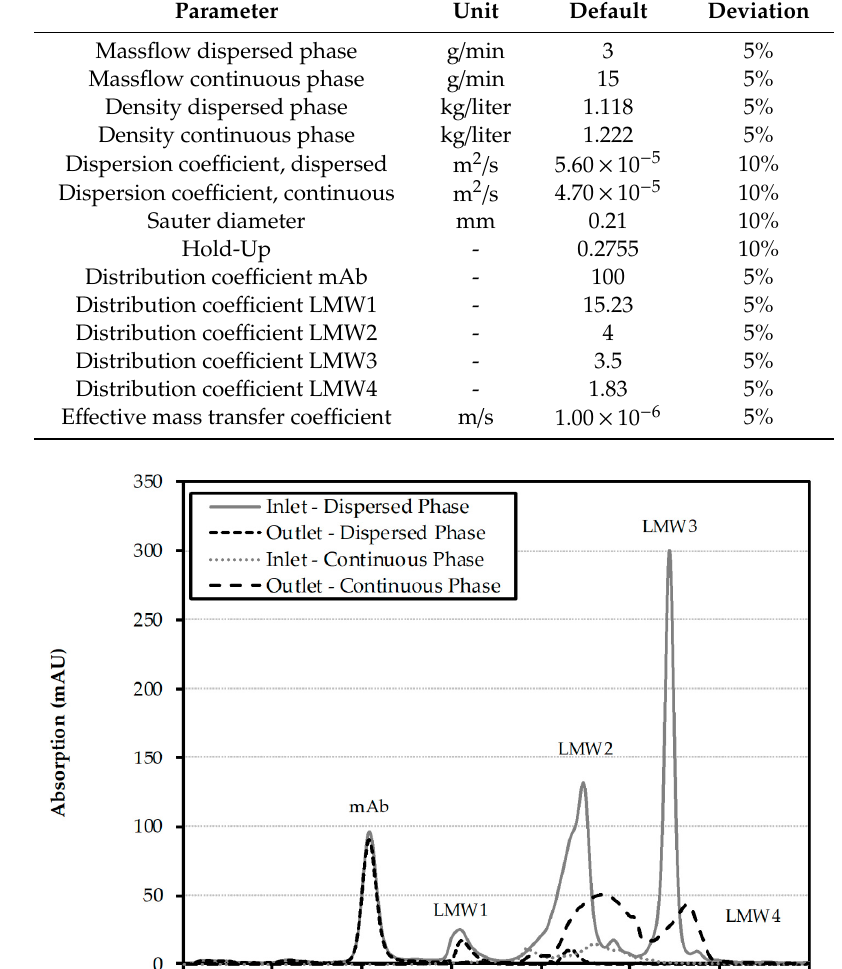
Table 6. Process and model parameters for the wash extraction from [7]. The default values of the simulation equal the experimental process parameters. The dispersed phase enters the column at the bottom; the continuous phase inlet is at the column top.